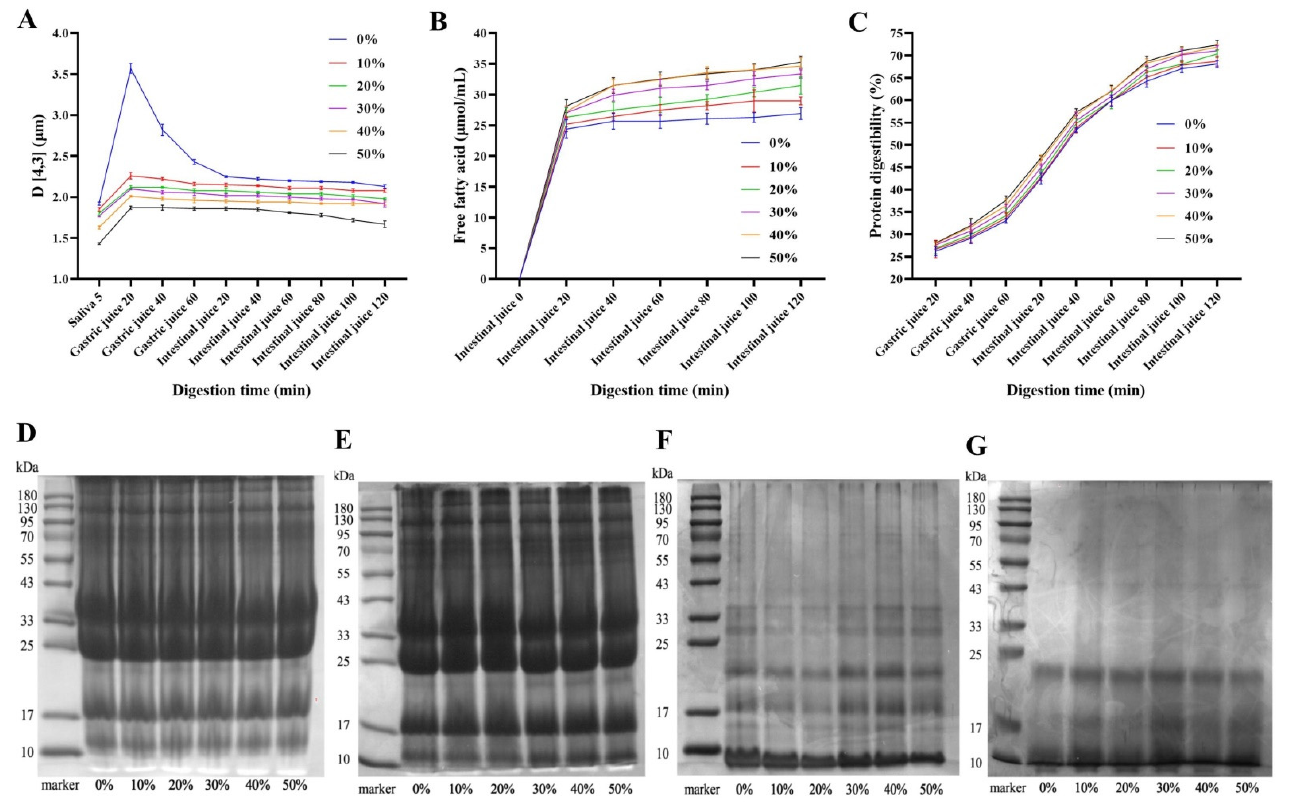
Figure 5. Effects of different SOB substitution amounts on digestive properties of ice cream, they should be listed as: ( A ) average particle size; ( B ) free fatty acid; ( C ) protein digestibility; ( D ) not digested; ( E ) digestive in artificial saliva for 5 min; ( F ) digestive in artificial gastric juice for 60 min; ( G ) digestive in artificial intestinal juice for 120 min.